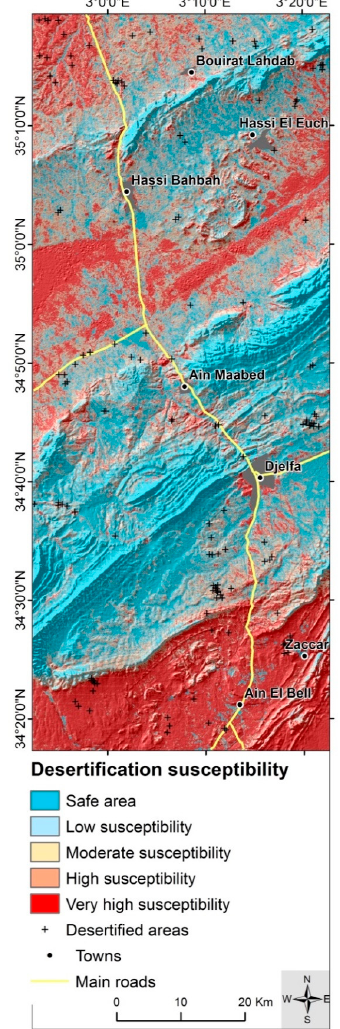
Figure 5. Desertification susceptibility map generated using a logistic model in the Djelfa